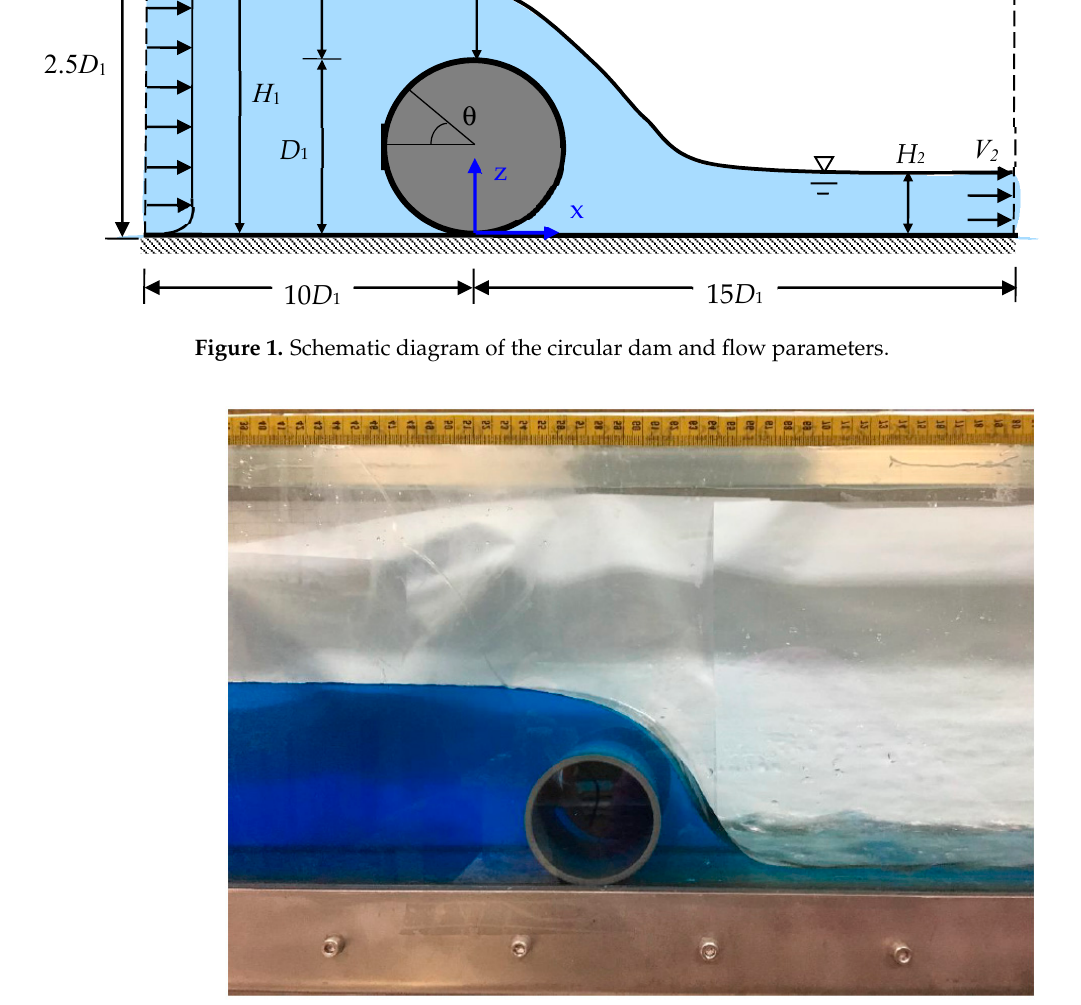
Figure 2. Photograph of the circular dam model in the flume experiment.